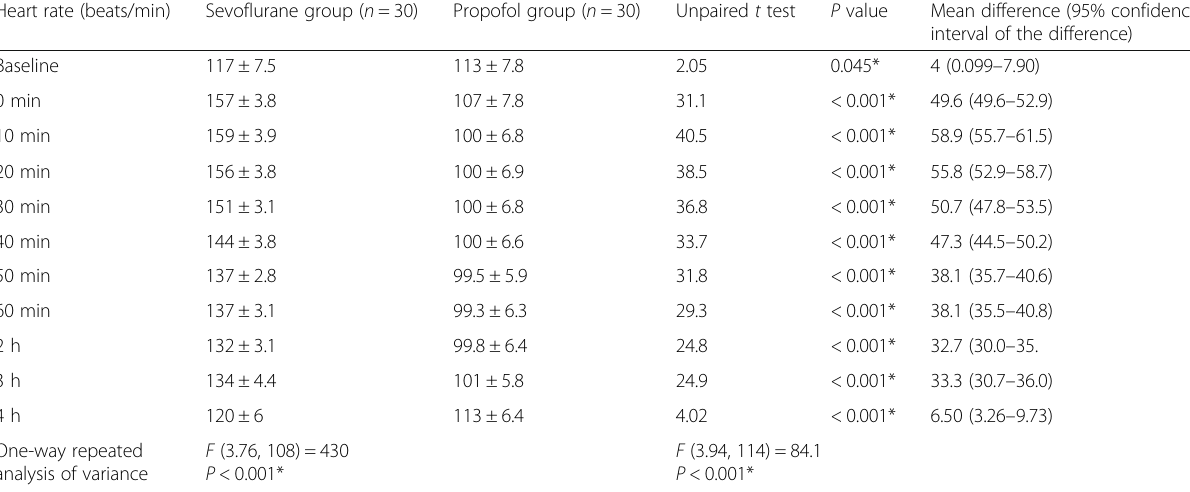
Table 2 Postoperative heart rate changes (beats/min) Heart rate (beats/min) Sevoflurane group ( n = 30) Propofol group ( n = 30) Unpaired t test